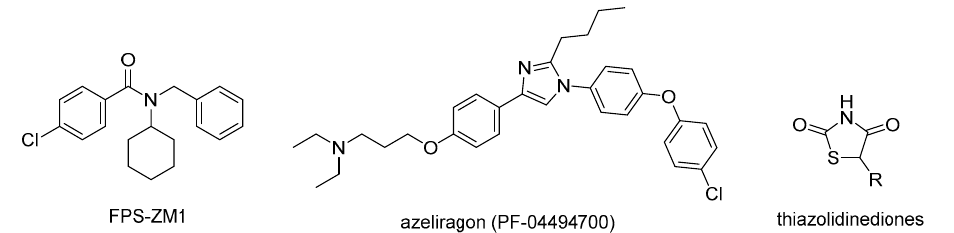
Figure 7. Structures of RAGE antagonists FPS-ZM1 and Azeliragon and the antidiabetic drug thiazolidinedione, which inhibits the formation of RAGEs.